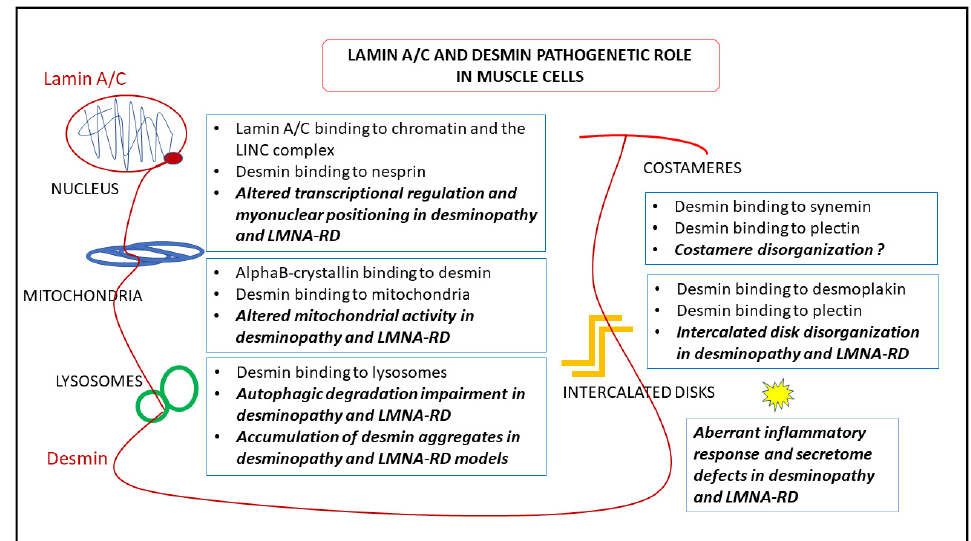
Figure 6. Lamin A/C and desmin potential pathogenetic role in muscle cells. Intracellular structures involved in lamin A/C and/or desmin-related functions and pathogenetic mechanisms related to each function are schematically represented. Lamin A/C and desmin are represented as dark red filaments. Desmin filaments connect all represented organelles and structures in skeletal or cardiac muscle (intercalated disks specifically in the heart). Each box refers to the adjacent structure. Pathogenetic events are written in bold characters in each box. Downstream of all pathogenetic events, aberrant inflammatory response and secretome defects contribute to disease progression (lower right box).